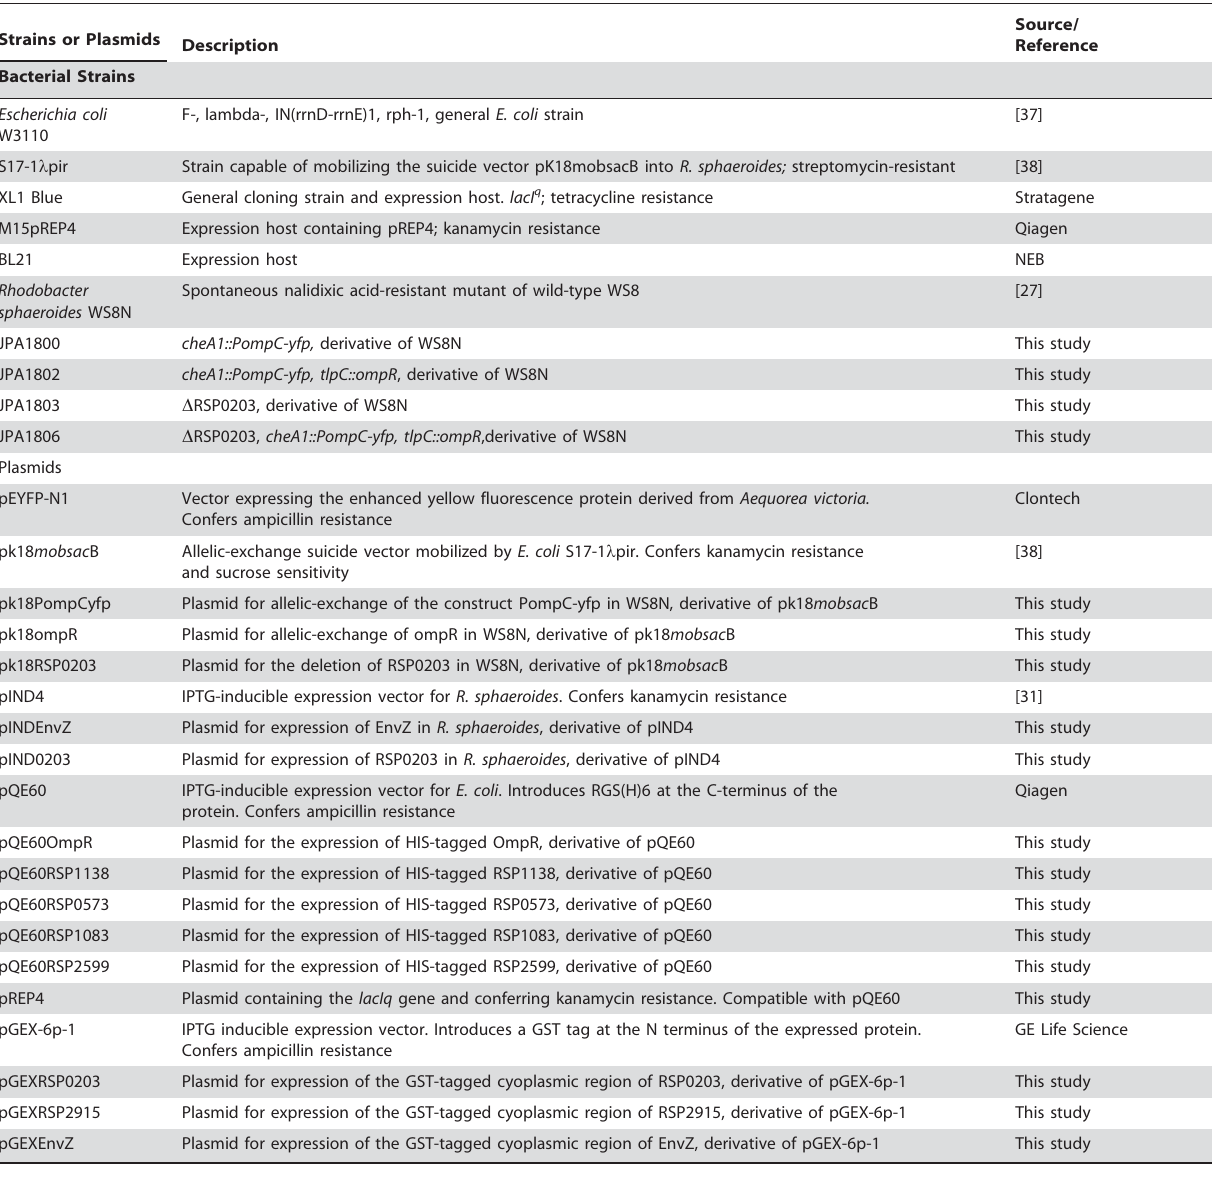
Table 3. Table of strains and plasmids used in this study.